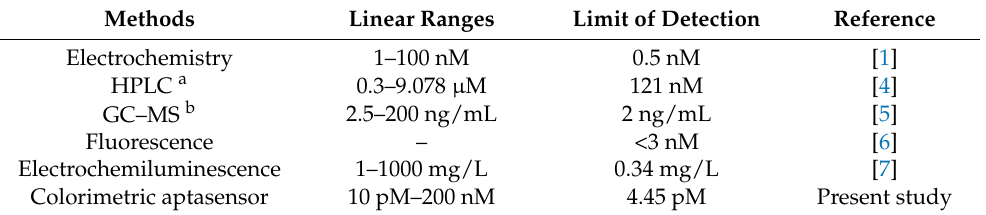
Table 1. Comparison with reported methods for anatoxin-a detection.